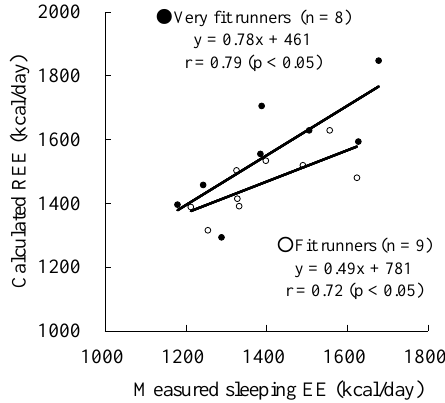
Figure 1. Box-plot diagram for comparing measured sleeping energy expenditure and estimated resting energy expenditure. EE: energy expenditure; REE: resting energy expenditure.